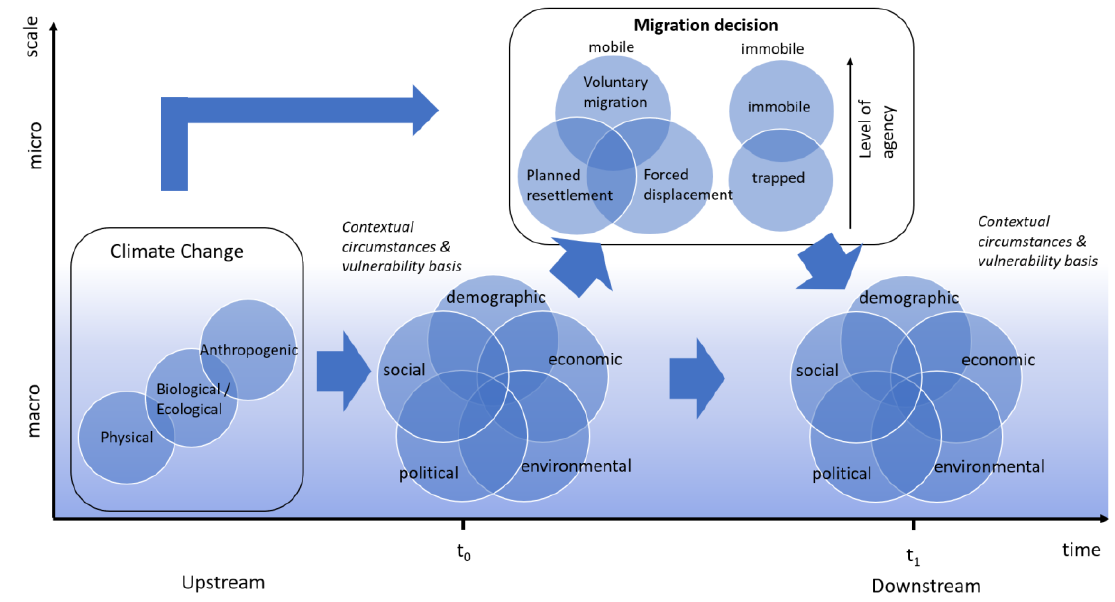
Figure 1. A conceptualisation of the pathways through which climate change may impact upon a system of vulnerability determinants that influence an individual’s migration decision.